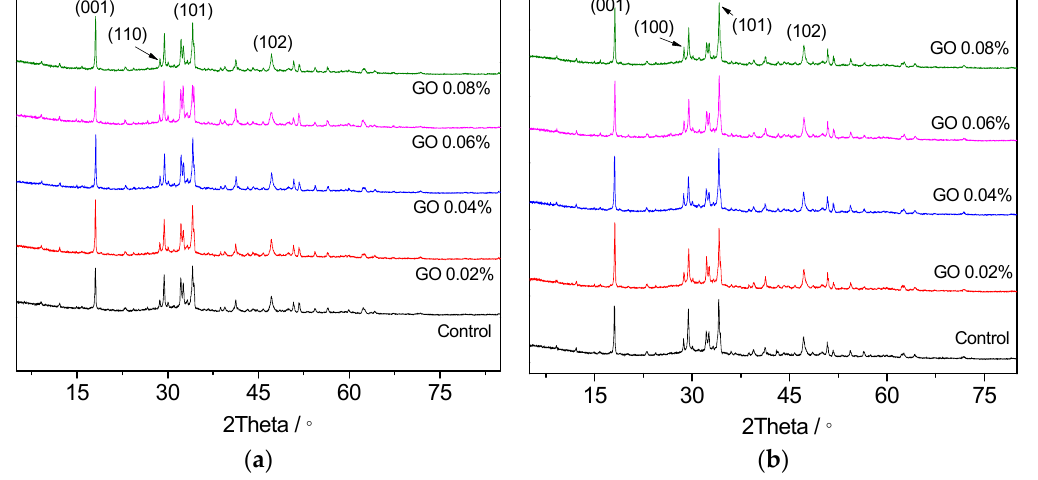
Figure 6. XRD patterns of hydration products. The CH crystal peaks were shown in both plots. ( a ) 3 days; ( b ) 28 days.